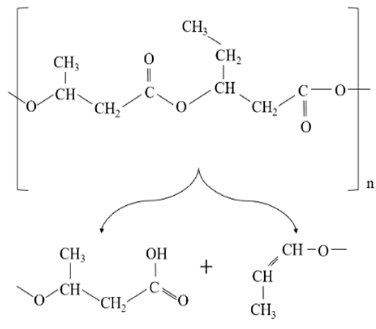
Figure 1. Schematic diagram of poly (3-hydroxybutyrate- co -3-hydroxyvalerate) (PHBV) random chain scission during thermal degradation.